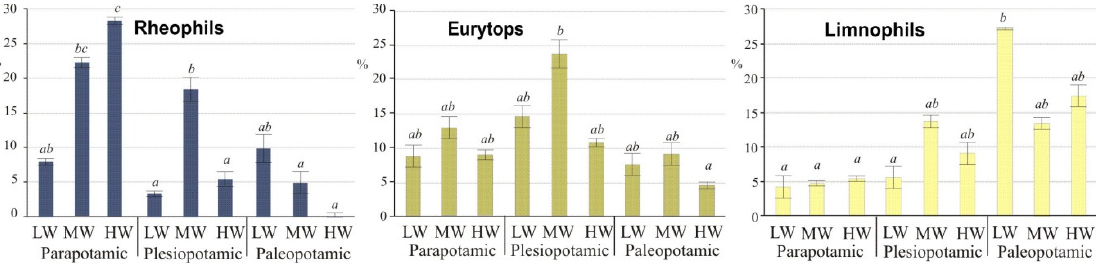
Figure 4. Effect of water level on the ecological fish guilds in floodplain lakes differed by hydrological connectivity: LW, low water; MW, mean water; HW, high water. Different letters denote groups of means, statistically different in the Duncan’s test, post-hoc , two-way ANOVA, at p ≤ 0.05. Hierarchical cluster analysis (HCA) performed on the percentage of species abundance in nine lake-sites produced four clusters of objects (Figure 5). Cluster I covered lentic sites with a high percentage of limnophils (56%) and complementary species, mainly eurytops. The cluster comprised the predominant species in lentic habitats: the Prussian carp, crucian carp, sunbleak, bitterling and weatherfish. Cluster II was characterized by a significant share (58%) of eurytopic species. Clusters